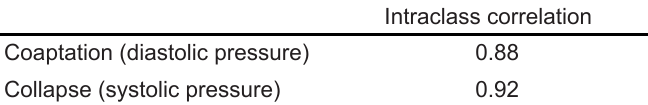
Table 4. Correlation between the two observers to identify on ultrasound the point of initial coaptation of radial arterial walls (diastole) and complete collapse